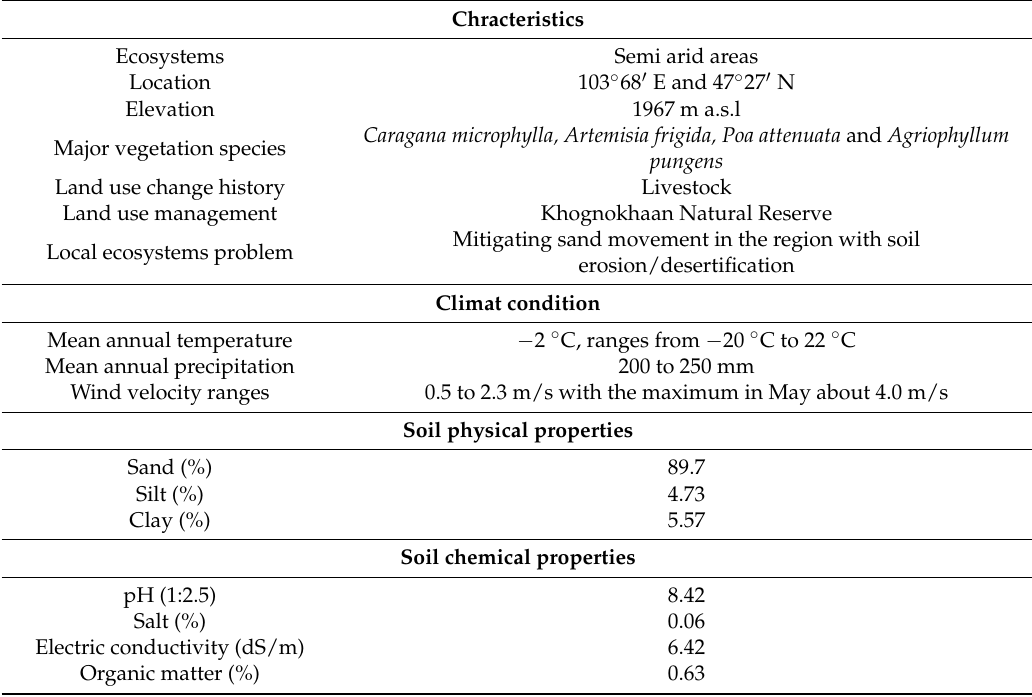
Table 1. Summary of chracteristics of the study site.